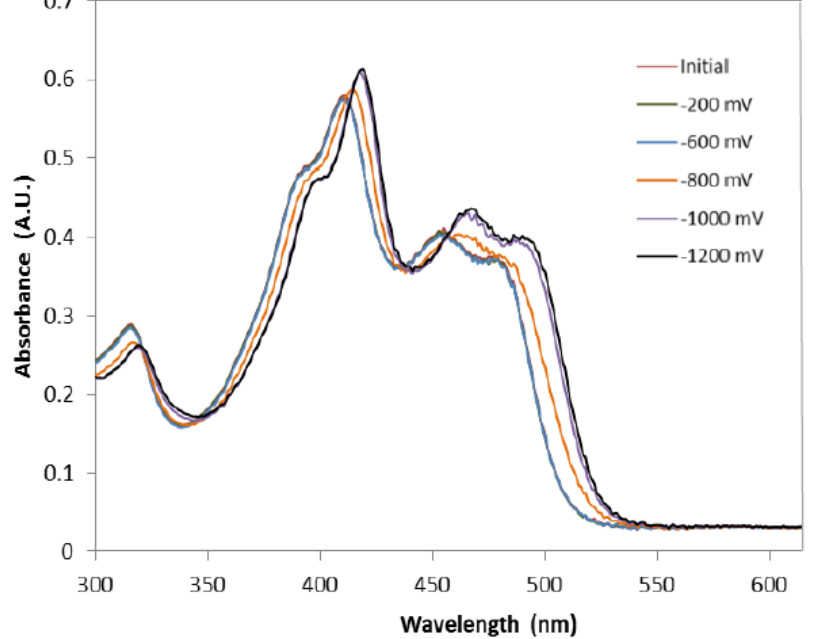
Figure 12. Overlaid optical absorption spectra from 300–650 nm of the + 2Zn2 hydrazone complex, Figure 12 . Overlaid optical absorption spectra from 300–650 nm of the +2Zn2 hydrazone complex, ~100 µ M, in acetonitrile after equilibration at potentials ranging from 0 to − 1.2V vs. Ag / AgCl. The first ~100 µM, in acetonitrile after equilibration at potentials ranging from 0 to −1.2V vs. Ag/AgCl. The first three spectra, 0 mV, − 200 mV, and − 600 mV, are three spectra, 0 mV, −200 mV, and −600 mV, are overlapped.